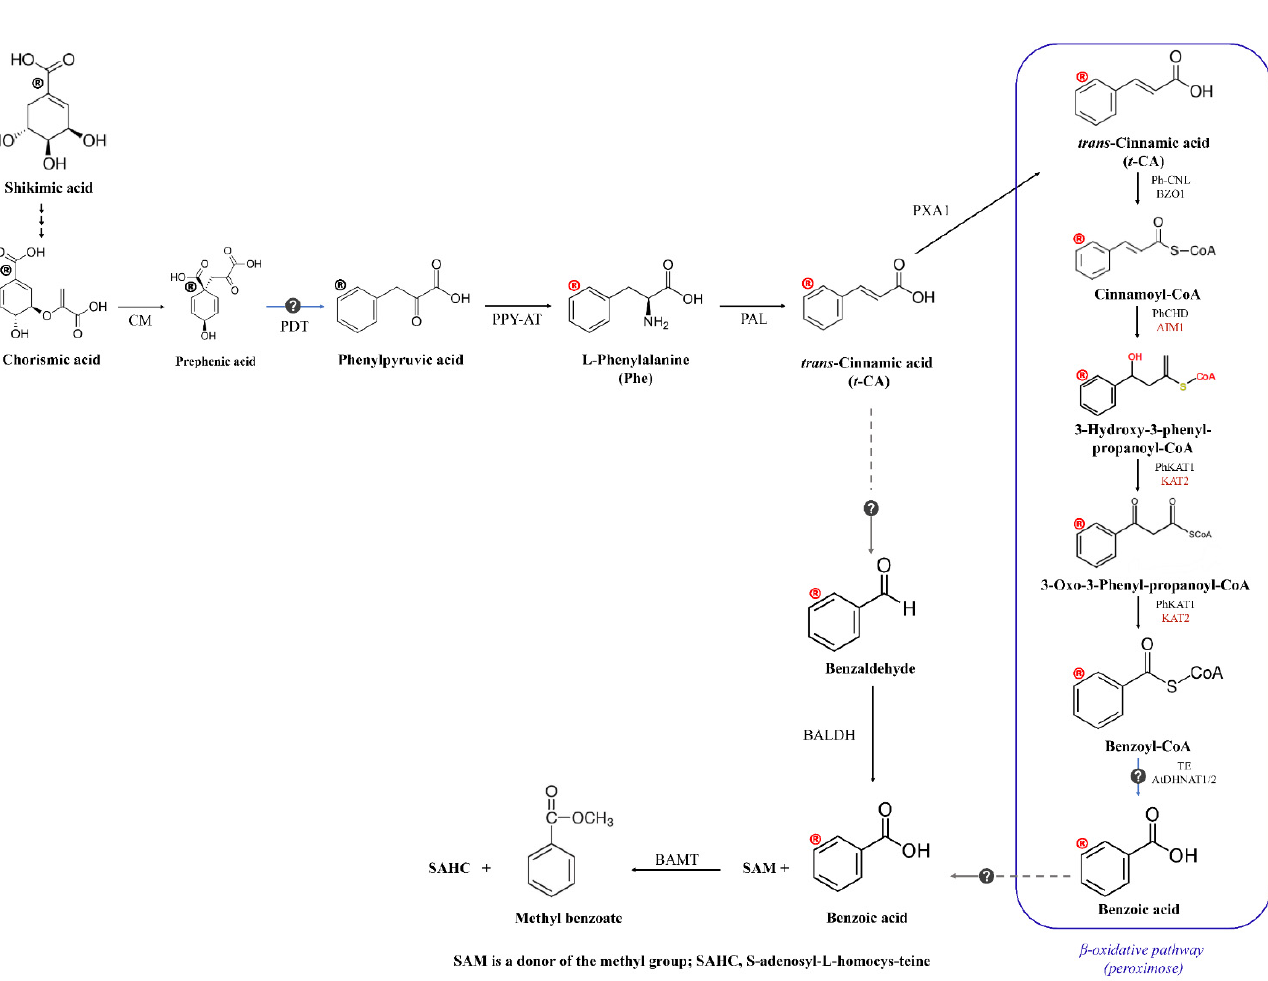
Figure 1. The biosynthesis network for plant benzoic acid. The shikimate/chorismate pathway proposed the biosynthesis of methyl benzoate in plants by the shikimate/chorismate pathway and via phenylalanine. The carboxyl carbon of shikimate is labeled (®), as is the β -carbon of phenylalanine (®). The plant enzymes involved in plant benzoic acid biosynthesis for which genes have been cloned are also indicated. Black and blue arrows show the existence and absence, respectively, of genetic evidence for a given reaction. Black and dark red enzymes indicate the presence and absence, respectively, of biochemical evidence for a given response. Question marks indicate the proposed steps with no available information. CM, chorismate mutase; PDT, prephenate dehydratase;